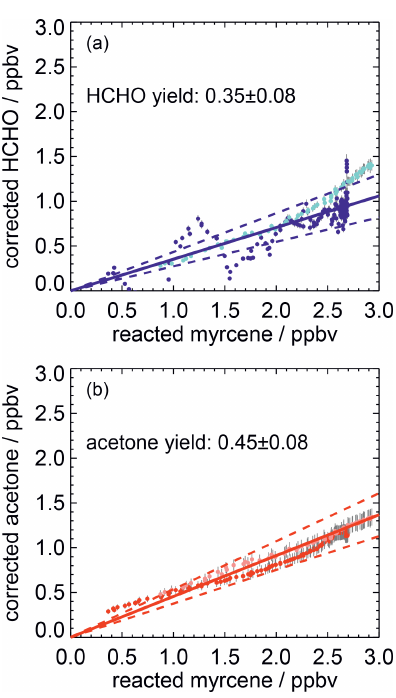
Figure 8. Corrected product concentrations vs. the myrcene that re- acted away with OH for two experiments with medium NO (light colours: 16 August 2012, dark colours: 22 August 2012). Correc- tions are applied to account for formation of product species not connected to the oxidation of myrcene (chamber sources) and loss processes (reaction with OH, photolysis). The slopes of linear fits (solid lines) give the product yields of HCHO and acetone from the myrcene reaction with OH. The uncertainties of the yield calcula- tions are indicated by dashed